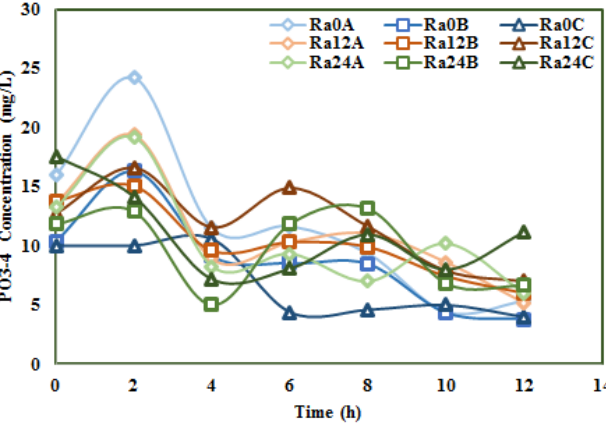
Fig. 4. Measured PO3-4 concentration at specified time for each reactor